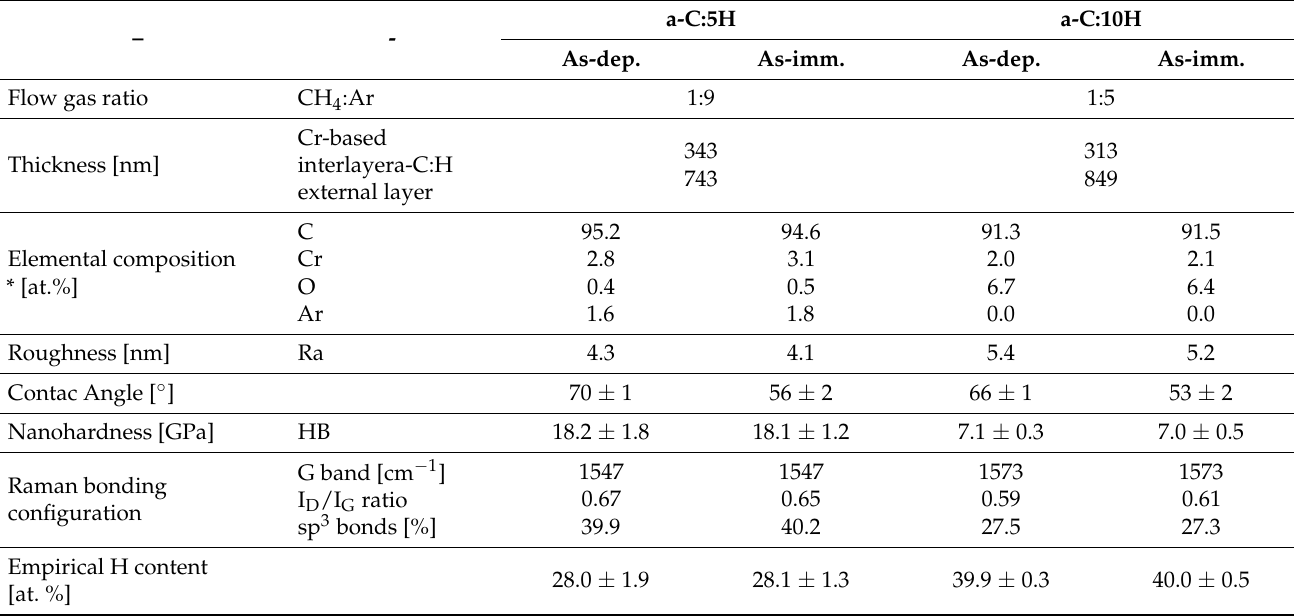
Table 2. Main characteristics of the a-C:H coatings in both as-deposited and as-immersed